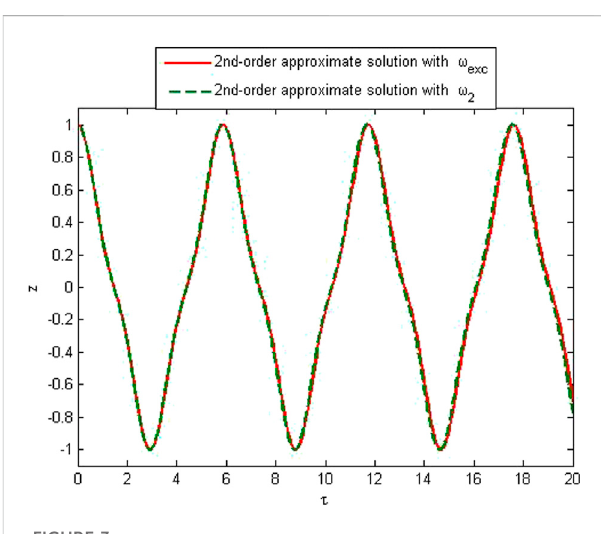
FIGURE 3 Illustration of the second-order approximate solution with A (cid:2)